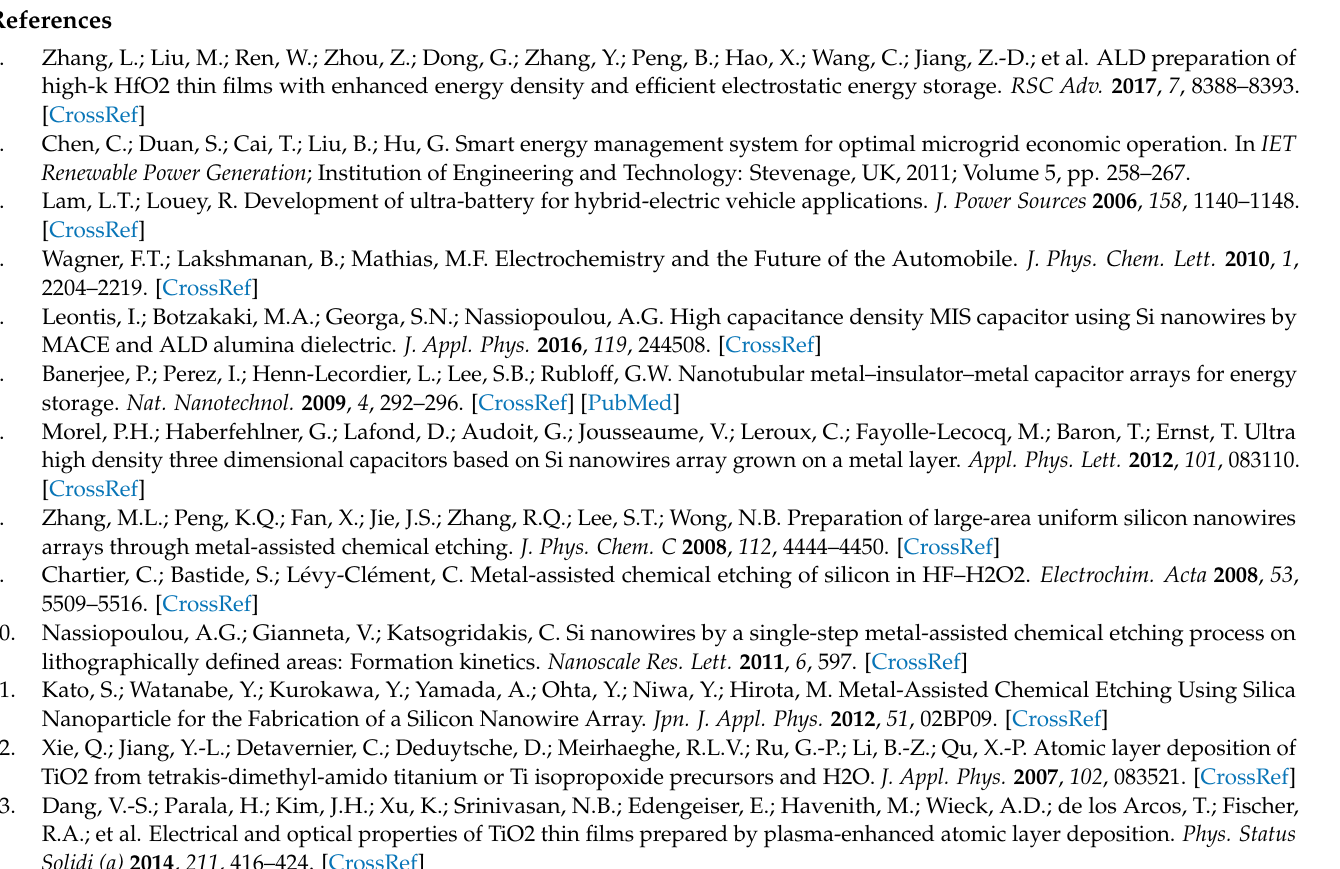
there is no strong band at 435 cm − 1 , TiO 2 is amorphous, Figure S2. Cross-sectional SEM image of a SiNW MOS capacitor after Al evaporation. Flakes of Al crystals can be seen from the top to middle of SiNWs. Since Al electrodes were deposited by thermal evaporation, SiNWs were not perfectly coated with Al, Figure S3. Energy band diagram and equivalent circuit of a MOS capacitor in the range of V < 0, Figure S4. C - V characteristics of (Dashed line) a flat MOS capacitor and (Solid line) Figure S5. Equivalent circuit approximation of a leaky MOS capacitor, Figure S6. C - V characteristics of the SiNW MOS capacitor with the length of 8 µ m measured at 50